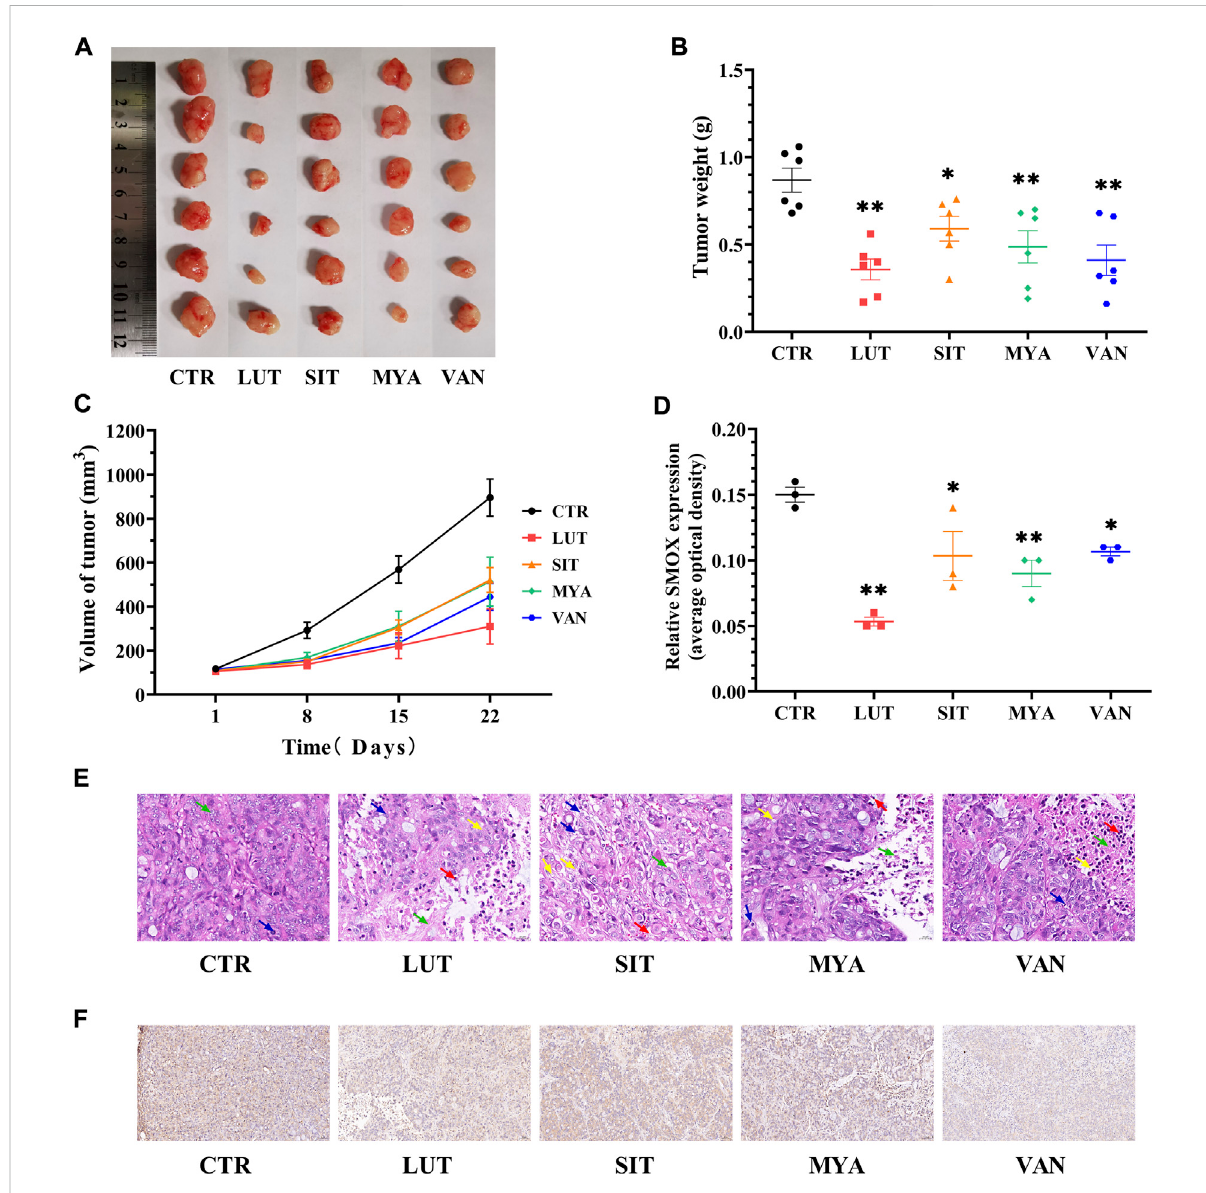
FIGURE 10 YFBP active ingredients inhibit in vivo HT-29 cell xenograft tumor growth. (A) Pictures of tumors taken after fi nal treatment. (B) Tumor weight measured after fi nal treatment. (C) Tumor size recorded during treatment. (E) HE staining of tumor. Scale bar = 20 μ m. The green arrow indicates tumor cell necrosis, the blue arrow indicates nuclear fragmentation, the yellow arrow indicates cytoplasmic vacuolization, and the red arrow indicates neutrophil in fi ltration. (D ,F) Immunohistochemistry for SMOX. Scale bar = 50 μ m. Quantitative results are shown as the mean ± SEM from three independent experiments. * p < 0.05, ** p < 0.01 vs. the CTR